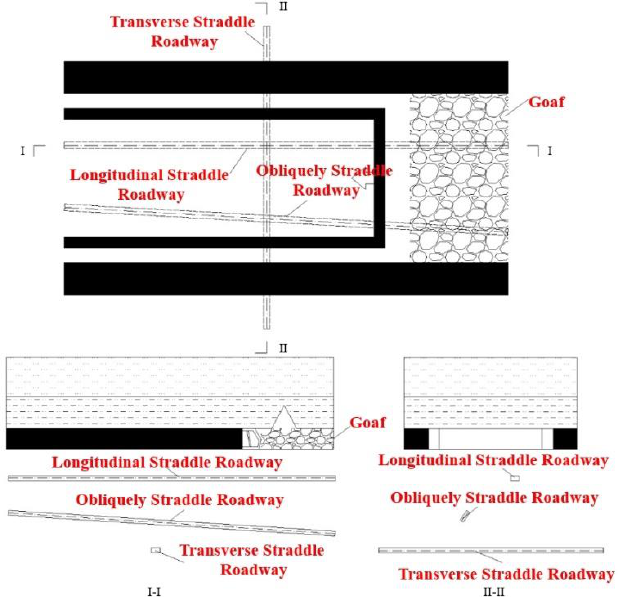
Figure 1. Layout diagram of rock roadway under overhead